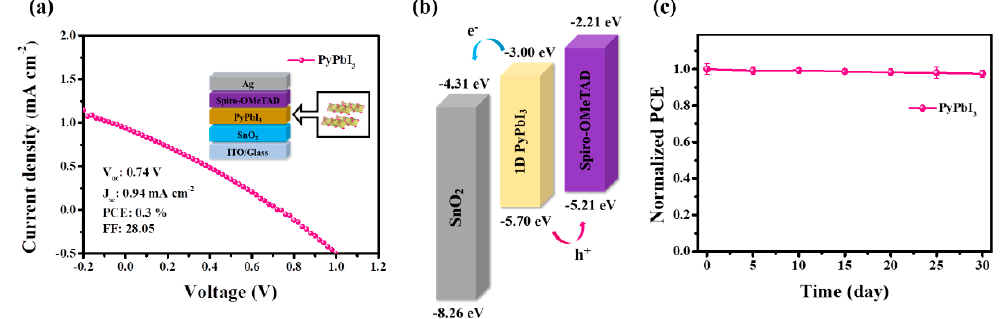
Figure 5. ( a ) J–V curve, ( b ) band energy diagram and ( c ) stability test of PyPbI 3 PSC. Inset: PSC devices schematic illustrations.